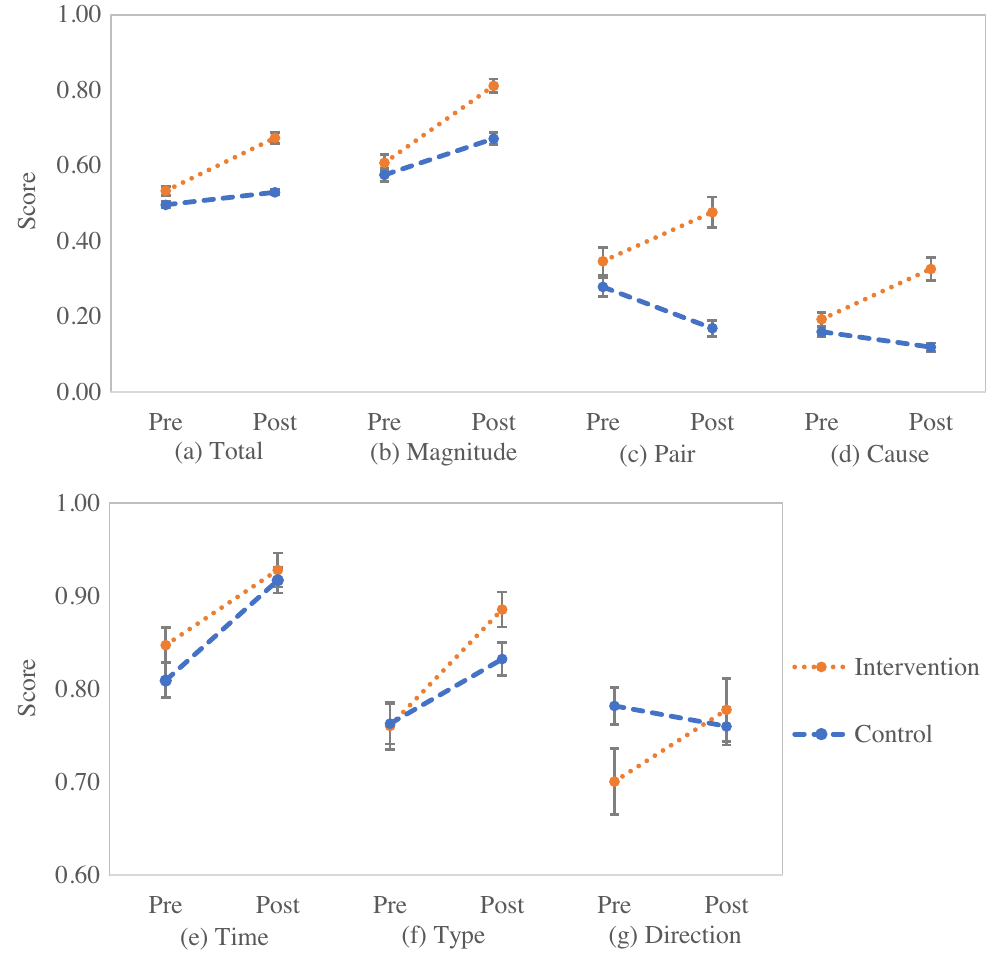
FIG. 5. Pre-post mean scores for the total score and each property: (a) Total, (b) magnitude, (c) cause, (d) time, (e) type, (f) interaction pair, and (g) direction. The error bars represent the standard errors of the means.